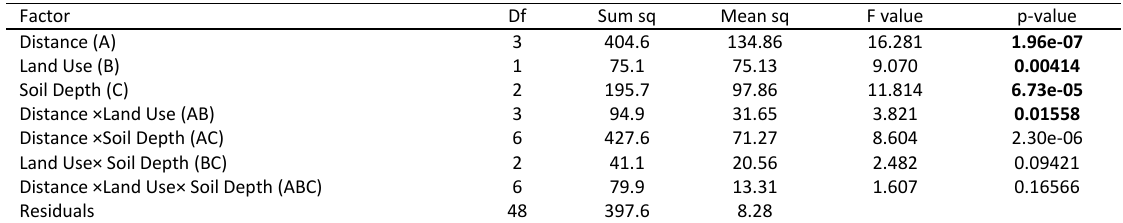
Table 2: Three-way ANOVA table for EC on distance (km) from the coastline, land uses (agriculture vs. fallow land) and soil depth. Significant differences are marked in bold in the table (α=0.05). Factor Df Distance (A)